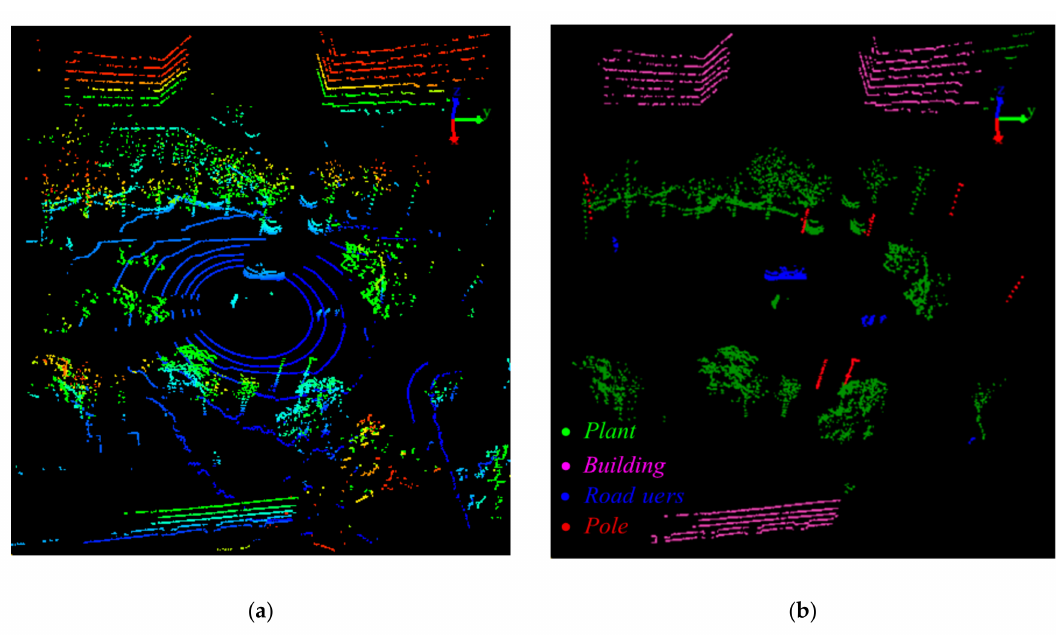
Figure 21. The results of semantic segmentation. ( a ) Original point cloud, where color means the height of points; ( b ) The results of semantic segmentation, where green objects belong to plants, violet objects belong to buildings, blue objects belong to the road users, and the red objects belong to